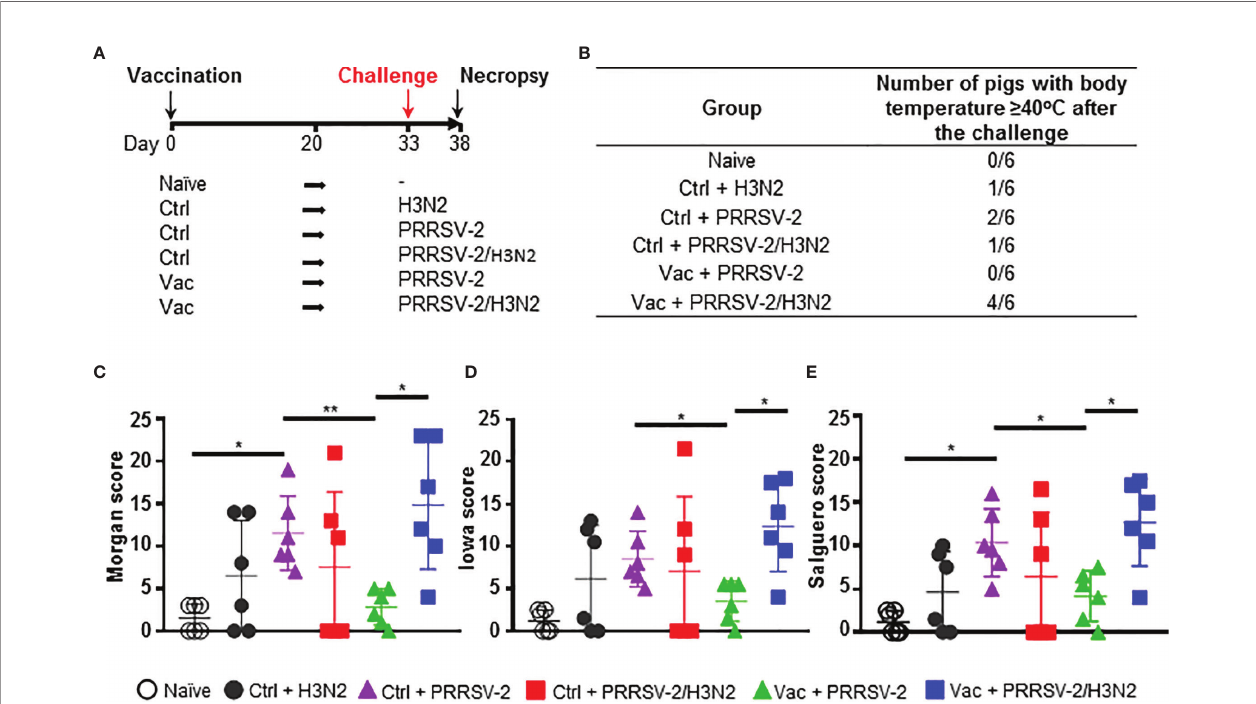
FIGURE 1 | Clinical signs and lung lesions. (A) Pigs were vaccinated intramuscularly with Ingelvac PRRS ® MLV (Vac) or with PBS (Ctrl) or were untreated (naïve). Thirty-three days after the vaccination, pigs were challenged by intranasal inoculation with H3N2, PRRSV-2 or simultaneously with PRRSV-2/H3N2. Nasal swabs were daily taken after the challenge and pigs were culled 5 days later [38 days post-vaccination (dpv)]. Sera and PBMC were collected at 0, 20 and 38 dpv. Clinical signs and rectal temperature were monitored daily after the challenge. (B) Table indicating the number of pigs that developed fever after the challenge. (C-E) Lungs sections were scored for histopathological lesions (C) ; Morgan score), lesions with presence of in fl uenza NP-positive cells (D) ; Iowa score) or lesions with presence of PRRSV N-positive cells (E) ; Salguero score). Each symbol represents an individual animal within the indicated group (n = 6 per group). The horizontal lines represent mean ± SD. Comparisons between 2 group were analyzed using Mann-Whitney test and asterisks indicate signi fi cant differences (*p < 0.05; **p <